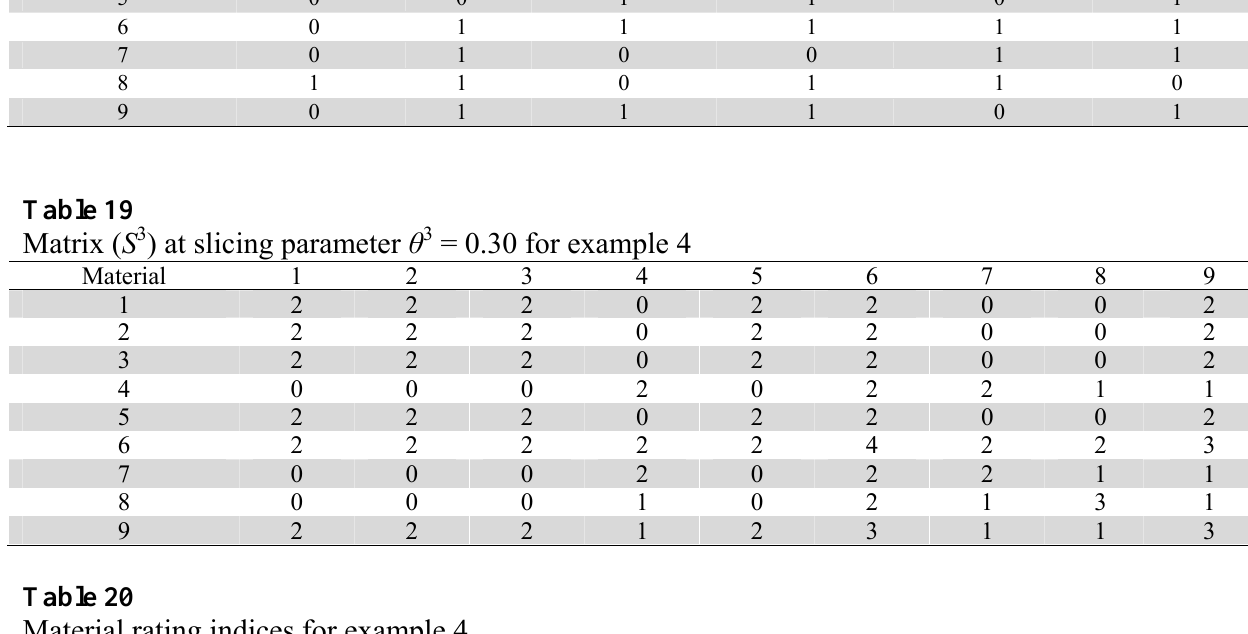
Material rating indices for example 4 Sl. No.